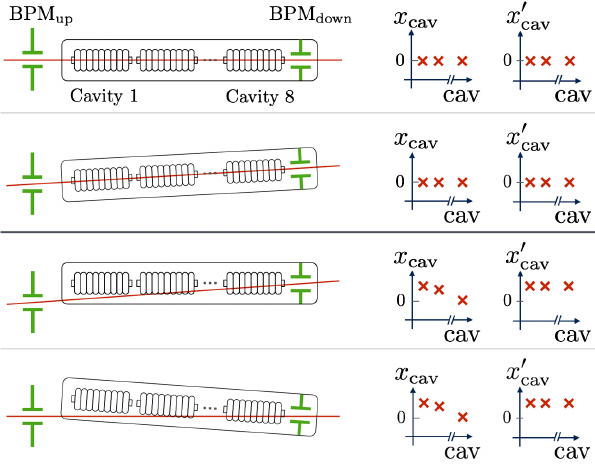
FIG. 15. Schematic drawing of the HOM-based cavity mis- alignment measurement setup as described in Fig. 5. The drawing illustrates exemplarily four module alignment scenarios (left) for the horizontal plane. The right-hand side shows the correspond- ing measurement result. The cavity offsets x measured with respect to the axis which is defined by the upstream and downstream BPM (red line). The latter BPM is located inside the cryomodule. The upper two and the lower two cases, respectively, are